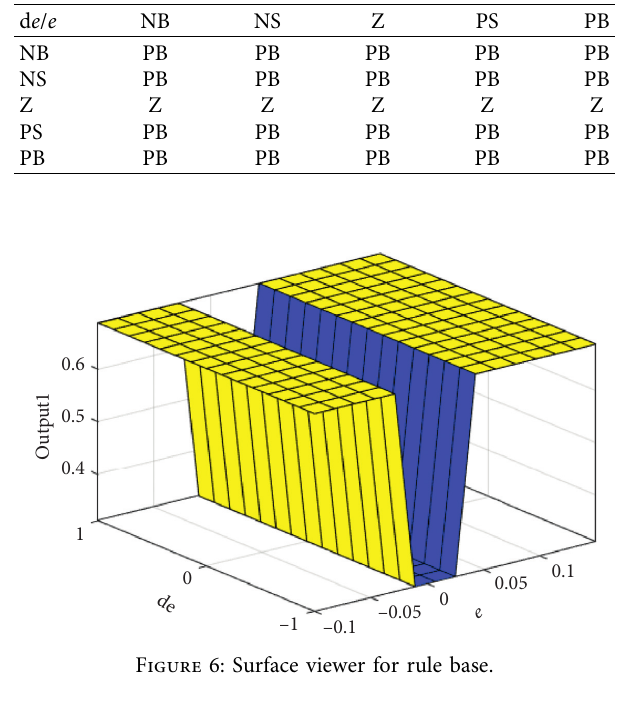
Model microgrid and IEEE 30 bus system using MATLAB/PSAT and integrating Simulate the power flow on the IEEE 30 bus system Record the voltage magnitude and phase angle of each bus